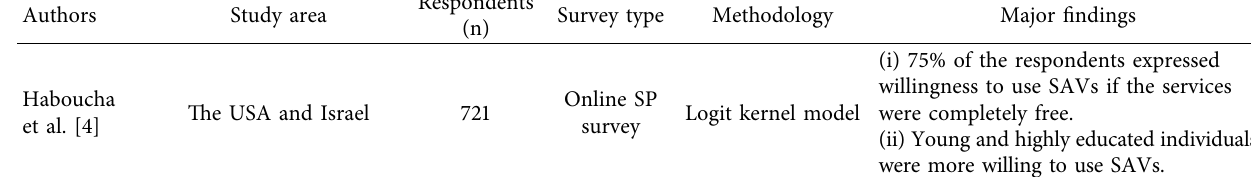
Table 1: Summary of current studies on public opinions and preferences toward AVs and